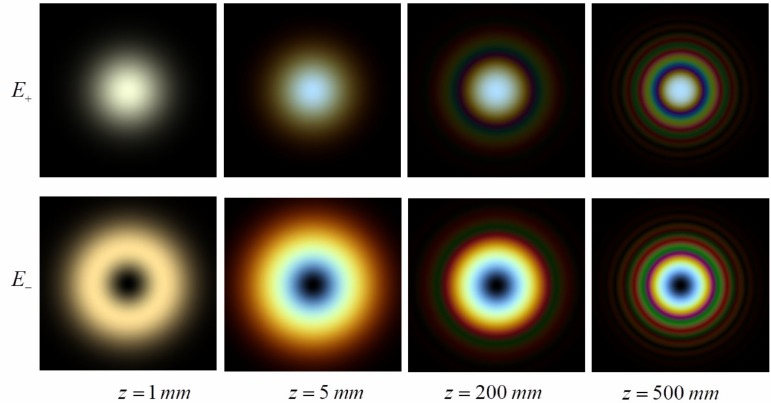
Figure 3. Generation of an optical vortex with a double topological charge in white light = 20 mkm in a lithium niobate crystal; image size along the x,y axes: ( l = 0, n = 0 ) with w 0 (cid:113) 5 w = 5 w 0 1 + ( z / z o ( 0.555 mkm )) 2